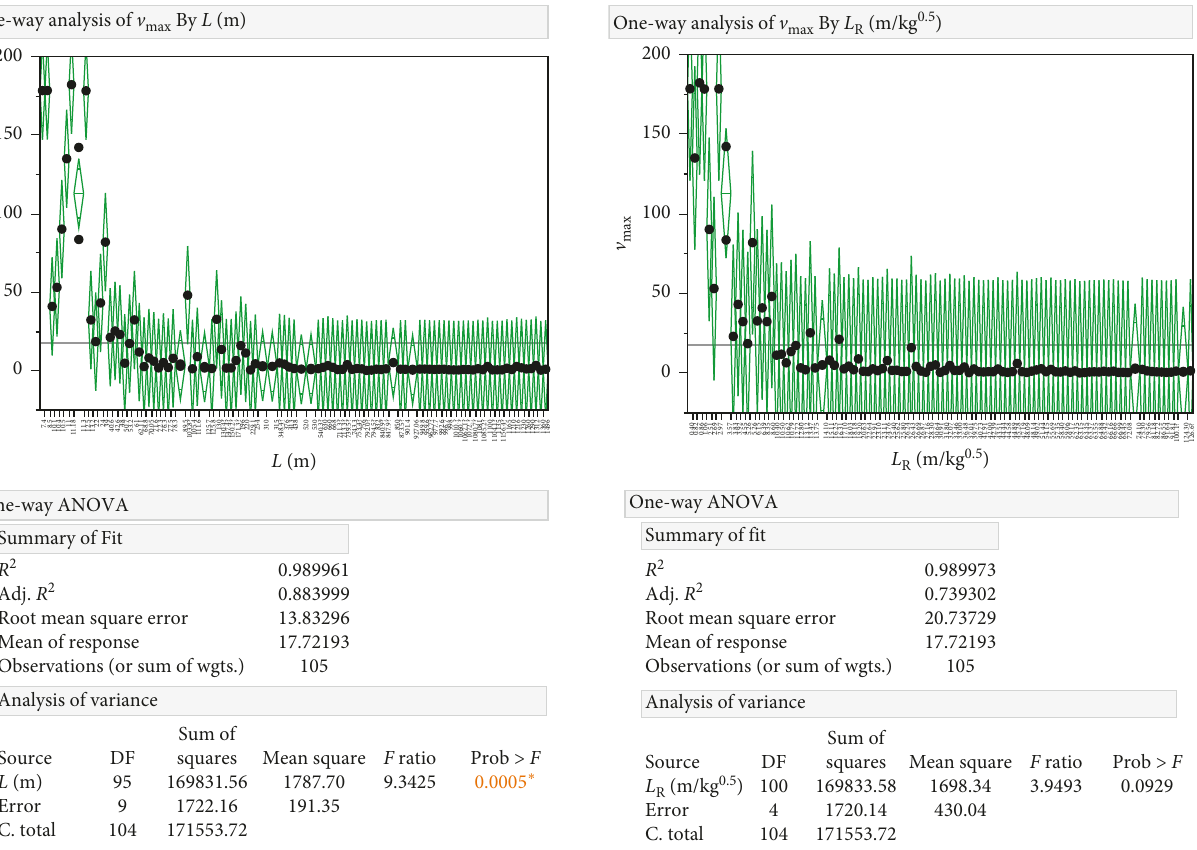
Figure 5: Analysis of v - L . Figure 6: Analysis of v max Figure 7). Three categories of intervals were established: < 0; 40 > ; (40; 220 > ; (220; more > .